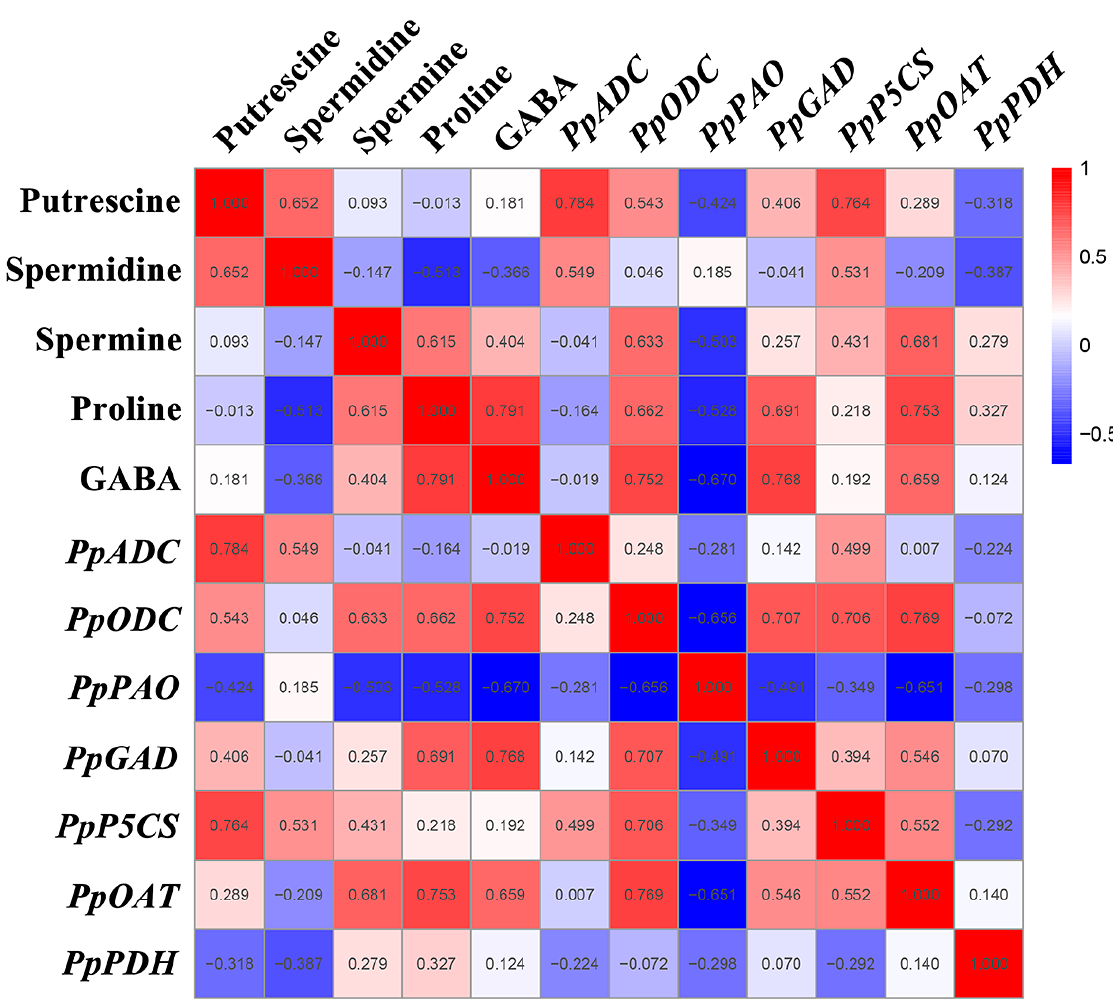
Figure 6. Thermal map analysis of the correlation of gene expression and PA, GABA, and proline content. The number represents the correlation coefficient, the red ground represents positive correlation, and the blue ground represents negative correlation.